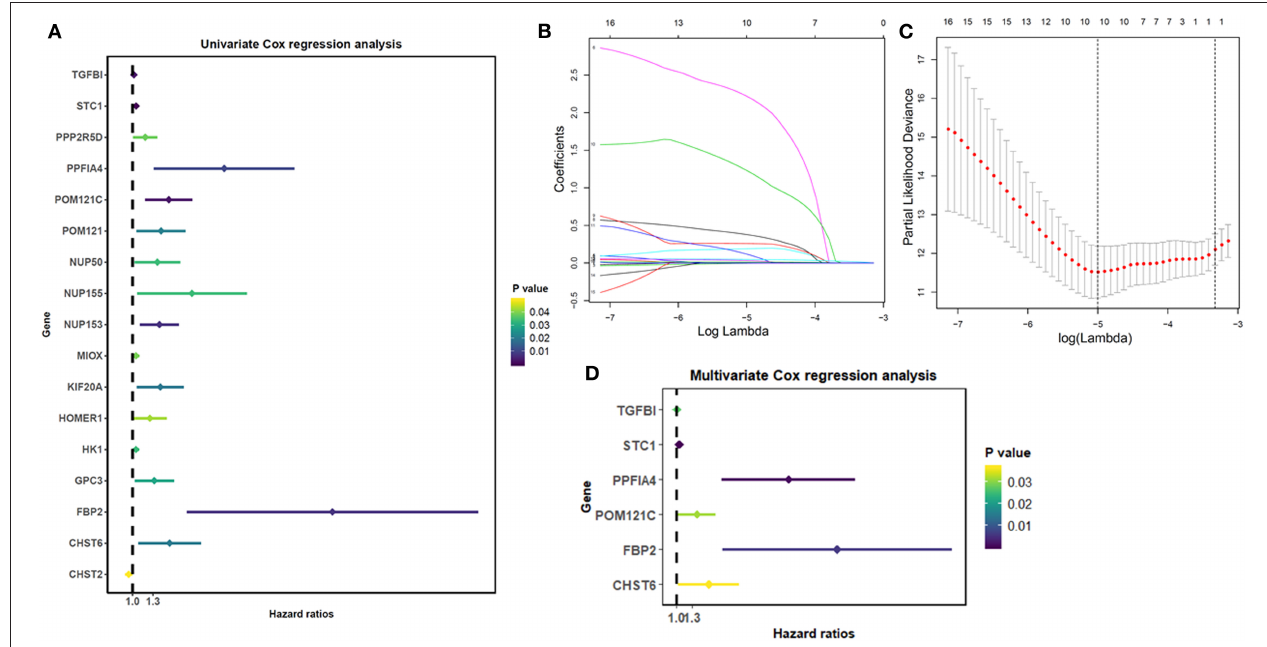
FIGURE 1 | Identification of glycolysis-related genes significantly correlated with patients’ survival. (A) The Univariate Cox analysis of glycolysis-related genes. (B) LASSO coefficient profiles of the glycolysis-related genes. (C) Plots of the cross-validation error rates. (D) Multivariate Cox analysis of glycolysis-related genes.